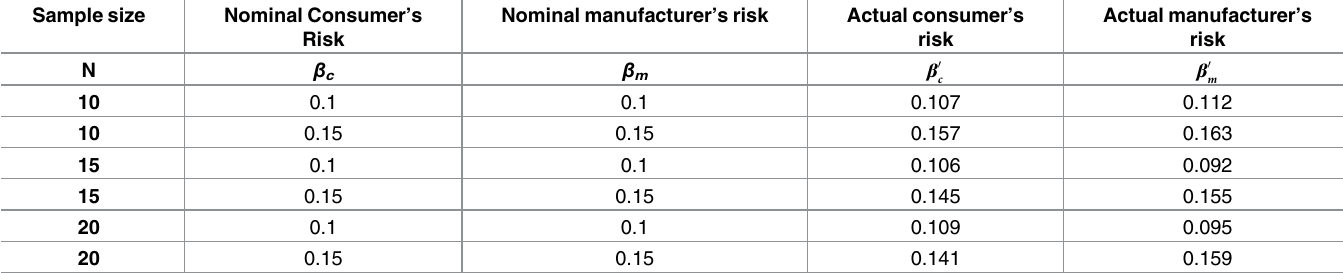
Table 7. Actual test risks under exponential distribution.